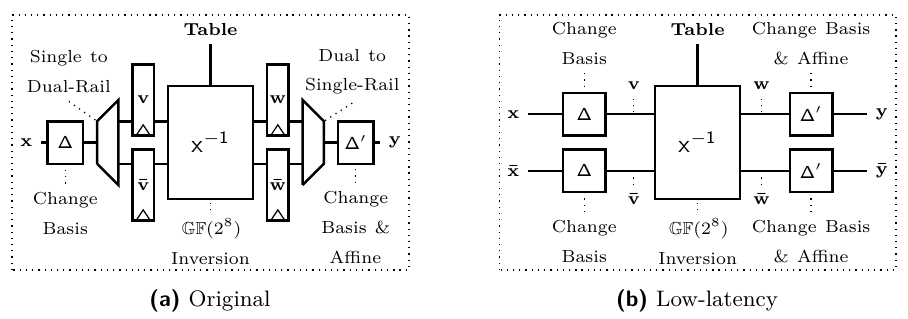
Figure 3: Comparison of the original and our low-latency LMDPL